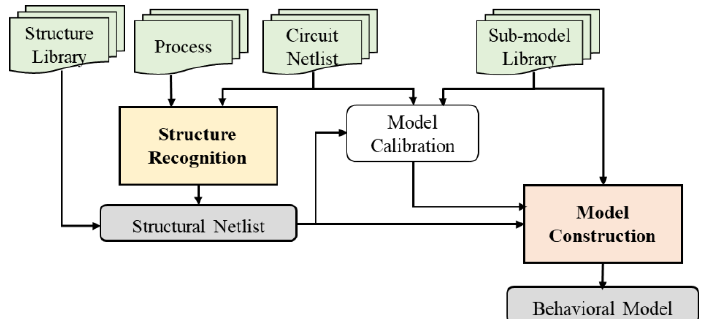
Figure 13. Behavioral model generation flow.